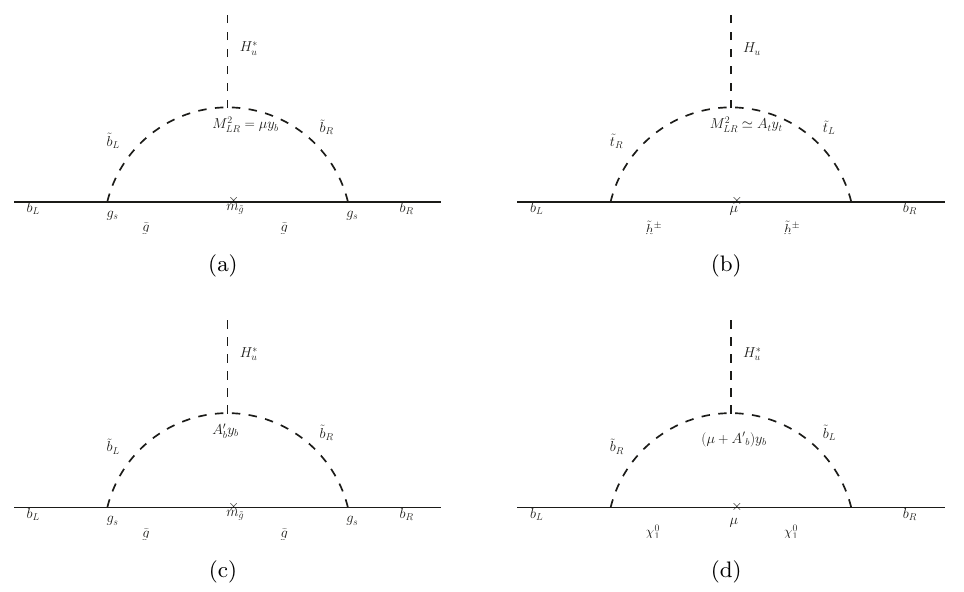
Figure 1 . Principal one-loop diagrams for (cid:1) m b in the MSSM ((a) and (b)) and the NHSSM ((c) and